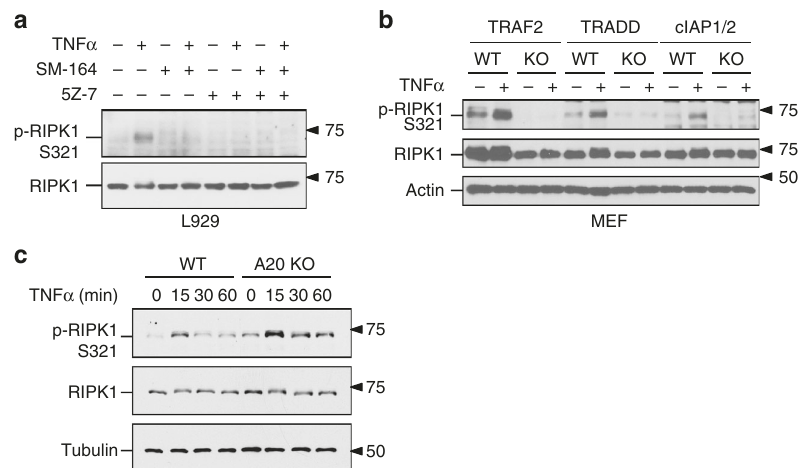
Fig. 3 Ubiquitination of RIPK1 is essential for its phosphorylation by TAK1. a SM-164 treatment blocks RIPK1 S321 phosphorylation in L929 cells. The cells were pre-treated by SM-164 (50 nM) and/or 5Z-7 (0.5 µ M) as indicated for 30 min, and incubated with TNF α (10 ng/ml) for 5 min. b RIPK1 S321 is not phosphorylated in the absence of TRAF2, TRADD or cIAP1/2. TRAF2, TRADD, cIAP1/2 KO MEFs and their corresponding WT MEFs were treated with TNF α for 5 min. c RIPK1 S321 hyperphosphorylation in A20 KO MEFs. A20 KO and WT MEFs were treated with TNF α and samples were collected at indicated time-points. The phosphorylation of RIPK1 S321 was analyzed by western blot using indicated antibodies a –